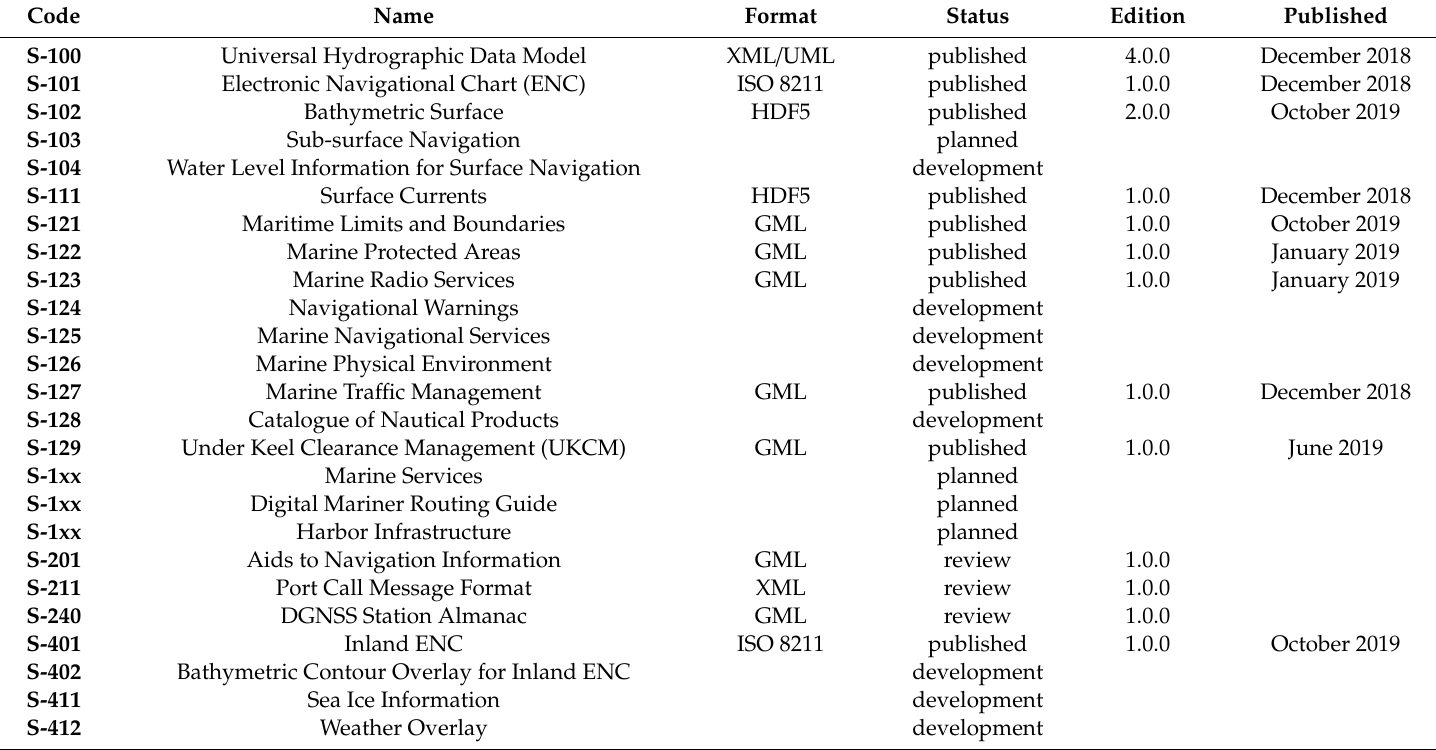
Table 2. S-100 Product specifications allocated by IHO Hydrographic Services and Standards Committee (HSSC) and their status (February